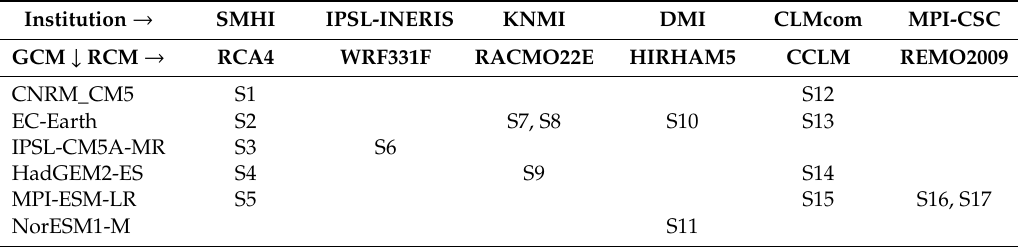
Table 1. General circulation model / regional climate model (GCM / RCM) combination matrix. S7 and S8, as well as S16 and S17 are combinations of the same GCM and RCM. They are di ff erent in terms of the GCM run with which the RCM was